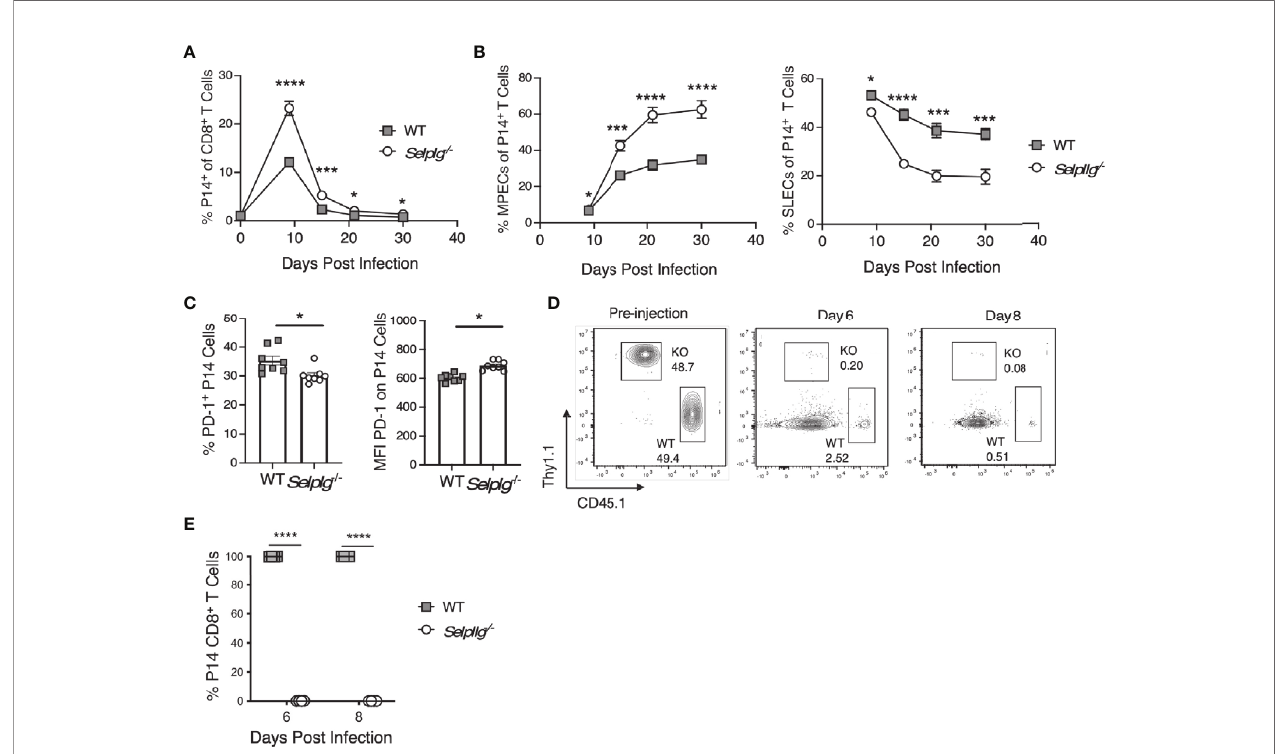
FIGURE 7 | Greater MPEC representation does not support Selplg -/- memory T cell responses after secondary viral challenge. WT and Selplg -/- memory P14 CD8 + T cells were isolated from the spleens of WT mice at 30 days after cotransfer in a 1:1 ratio and infection with LCMV Armstrong. These cells were then re-injected in equivalent numbers into WT naïve hosts and mice that were then infected with LCMV Armstrong. (A) The frequencies of WT and Selplg -/- P14 T cells in the blood with time. (B) The frequencies of the memory precursor effector cells (MPECs, IL-7R a + , KLRG-1 - ) and short-lived effector phenotype cells (SLECs: IL7R a - , KLRG-1 + ) as a % of WT and Selplg -/- P14 cells. (C) Frequencies PD-1 + cells and their and expression levels of PD-1 (MFI). (D) representative fl ow cytometry plots for the pre- injection populations of P14 cells, and (E) their recovery at 6 and 8 dpi (B) . Data are representative of three independent experiments (n = 5 or more mice/group). Graphs show the mean ± SEM * p < 0.05, *** p < 0.001, **** p < 0.0001 by two-tailed unpaired t-